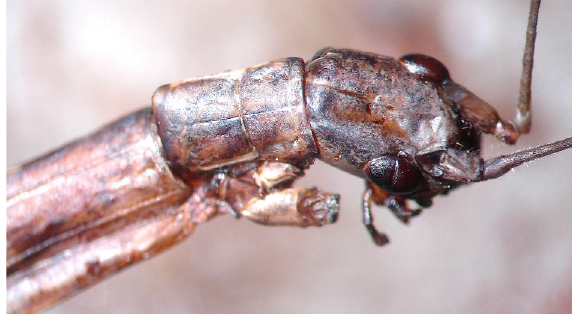
Image 2. Dorsal view of head, prothorax and part of mesothorax.